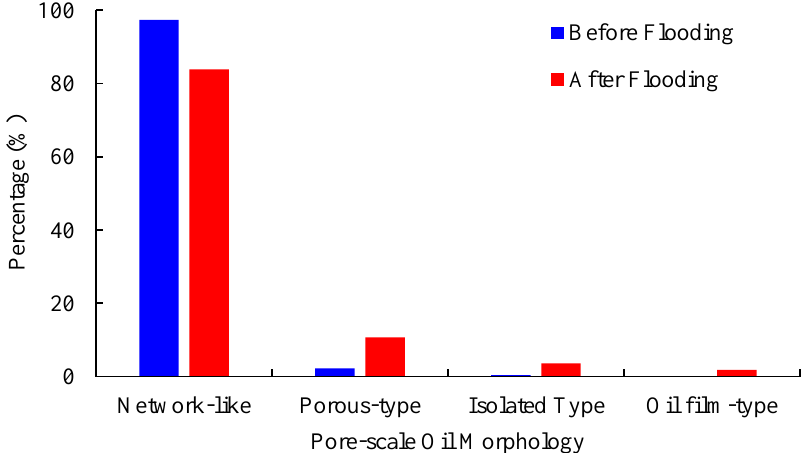
Figure 7. Pore-scale morphology of oil droplets during water flooding in No. 2 rock sample. Table 2. Geometrical analysis of residual oil droplets in No. 2 rock sample.